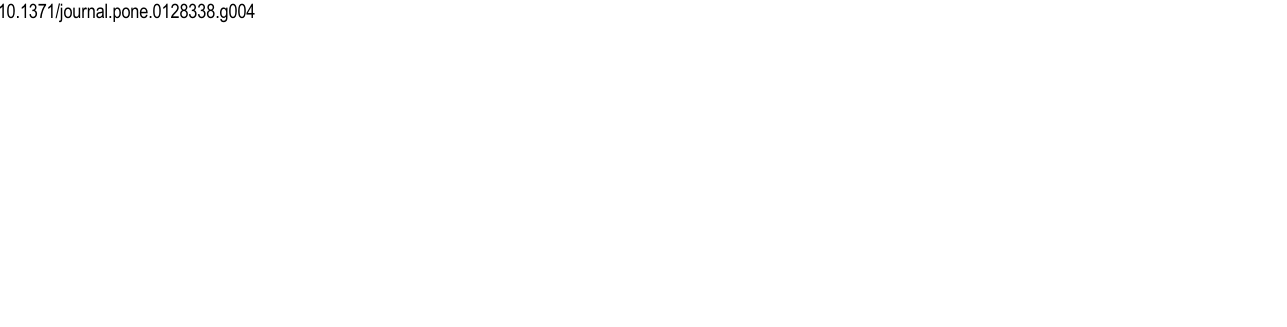
Fig 4. Gestures displayed during interaction with a touch screen by age decile. Caregivers ’ report of whether their child displayed an interactive gesture (red) or not (white), grouping children in ten equally-sized age groups. The limits of some of the age groups (in year;month) are given in the x-axis (see Fig 2 for full